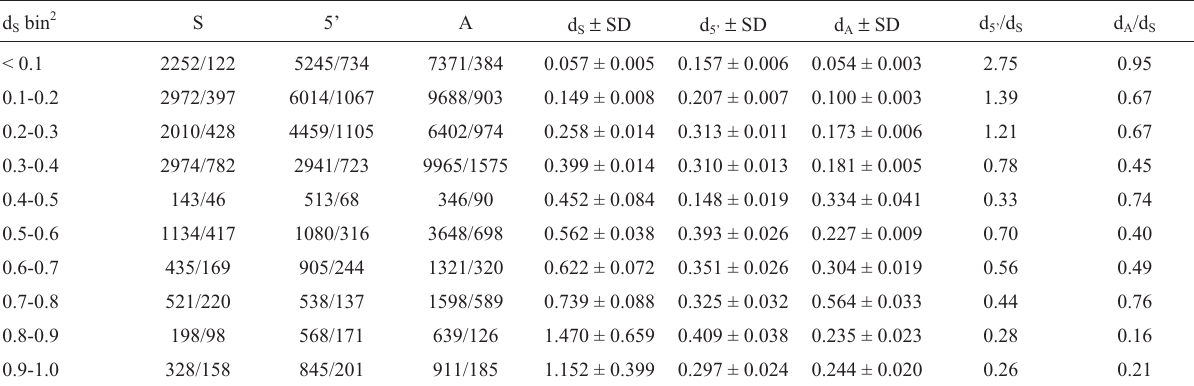
1 The number of sites surveyed in base pairs (first number) and the number of divergent sites (second number). 2 Divergence bins from Refs 1 and 2 and as described in